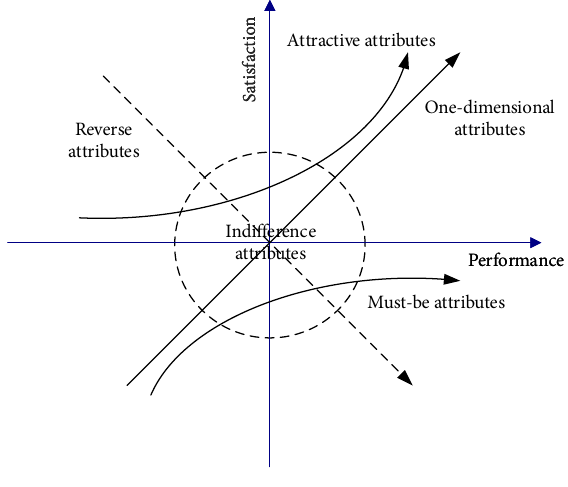
Figure 1. The Kano